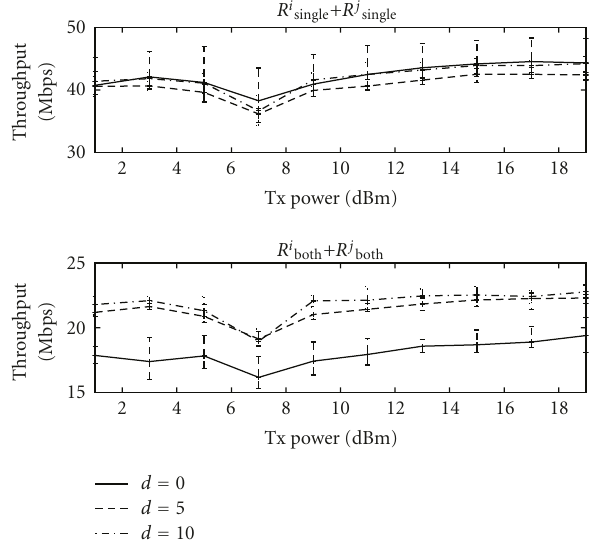
Figure 12: 802.11g links: impact of the channel distance and transmission power on the total